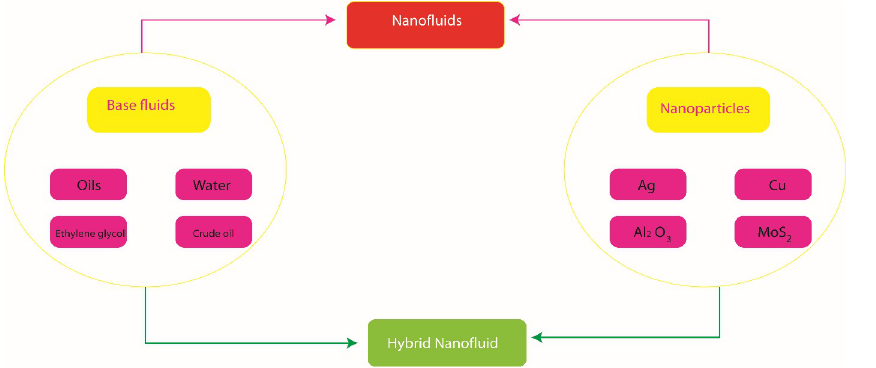
Fig 1. Manufacturing approach of hybrid nanoparticles and